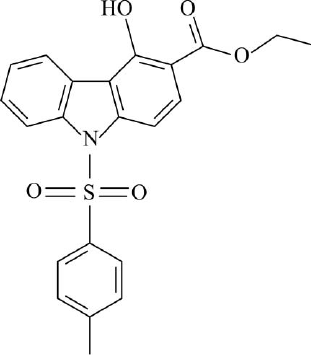
Experimental Crystal data